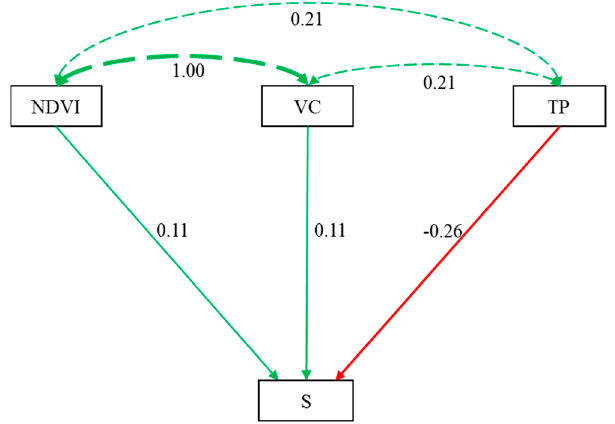
Figure 8. Path analysis between NDVI, VC, TP, and S of LES. The numerical value represents path coefficient; S represents ecological security index; LES represents land ecological security; NDVI represents normalized differential vegetation index; VC represents vegetation coverage; TP represents land surface temperature.